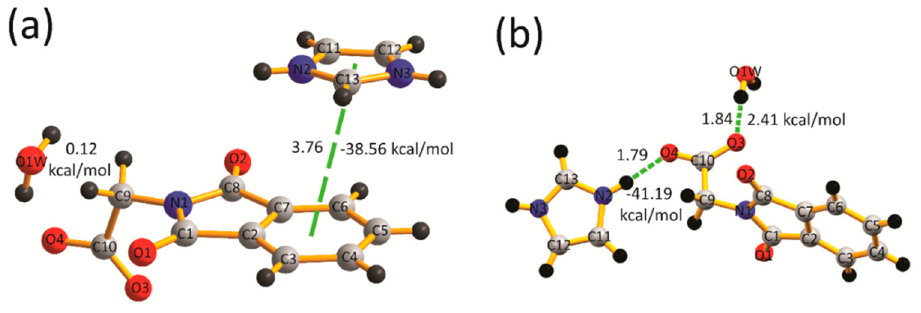
Figure 4. Two different configurations of IM + –NPG − –HYD in the supramolecular assembly: ( a ) A and ( b ) B . Distances of π – π stacking and hydrogen bonds are in angstrom, and the green line depicts the hydrogen bonds. The interfragmentary interaction energy between each IM + , NPG – , and H 2 O moieties is calculated via Hirshfeld charge analysis.